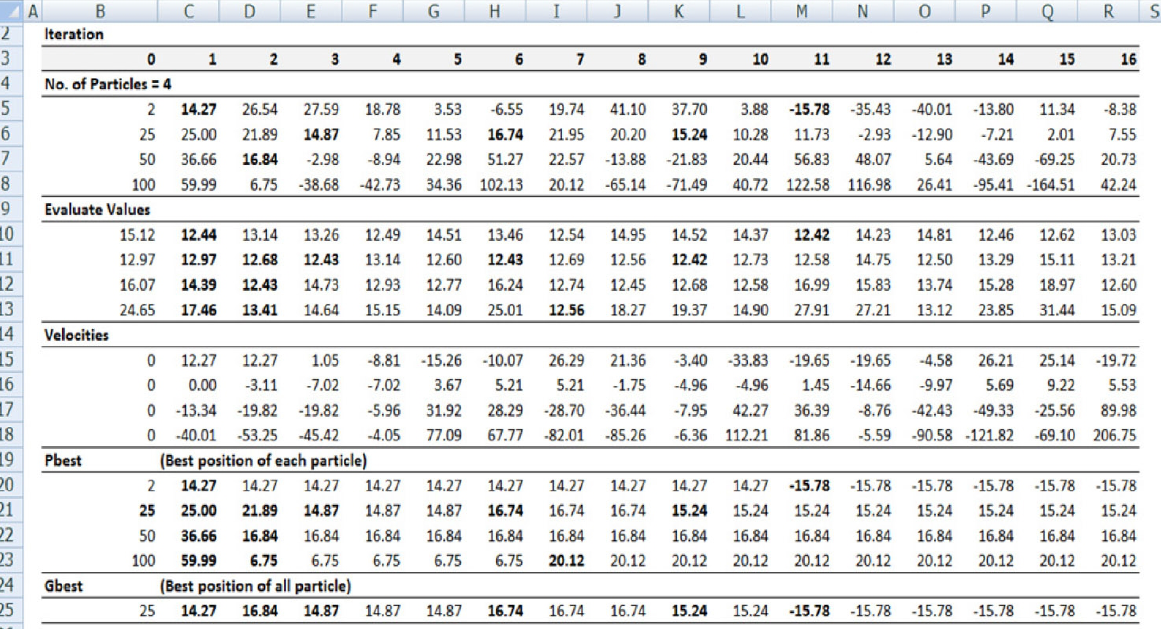
Table 2. Result from the particle swarm optimization